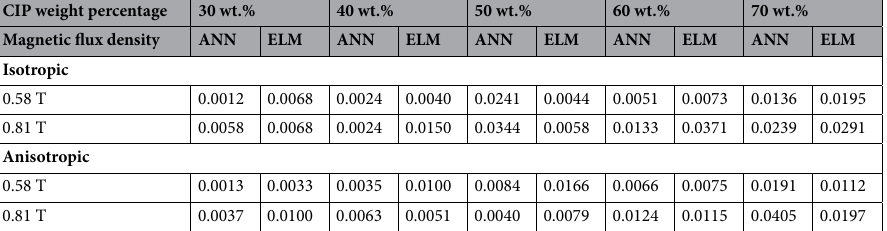
Table 8. The RMSE of absolute complex modulus on Ts2 data sets.